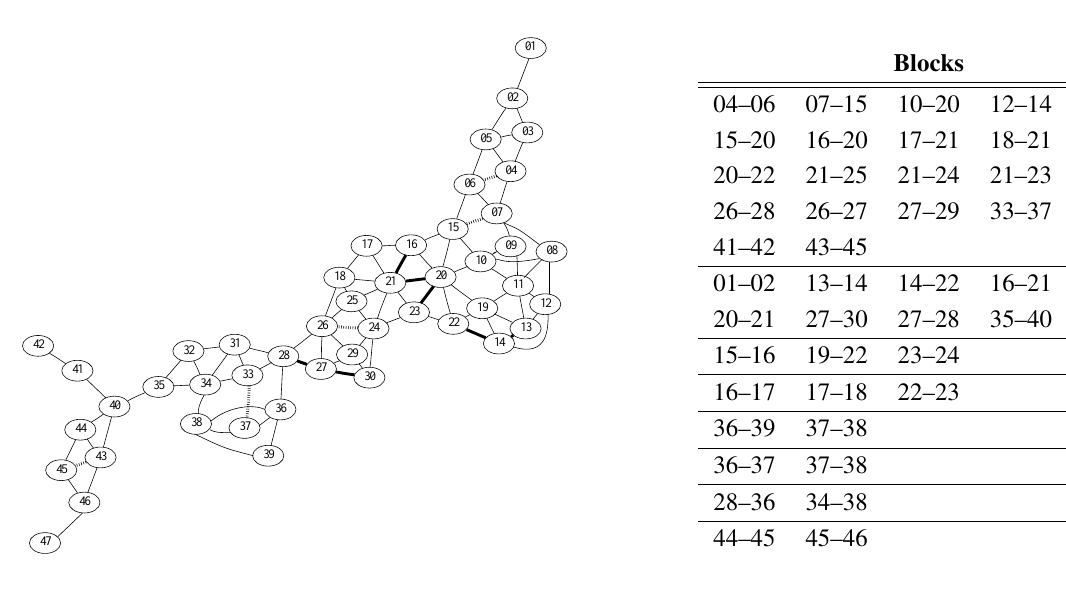
edge set ON consists of bold edges and OFF consists of dashed edges, the blocks of the corresponding co-occurrence partition except for blocks of single edges are shown in the right table as the collections of edges separated by horizontal lines.